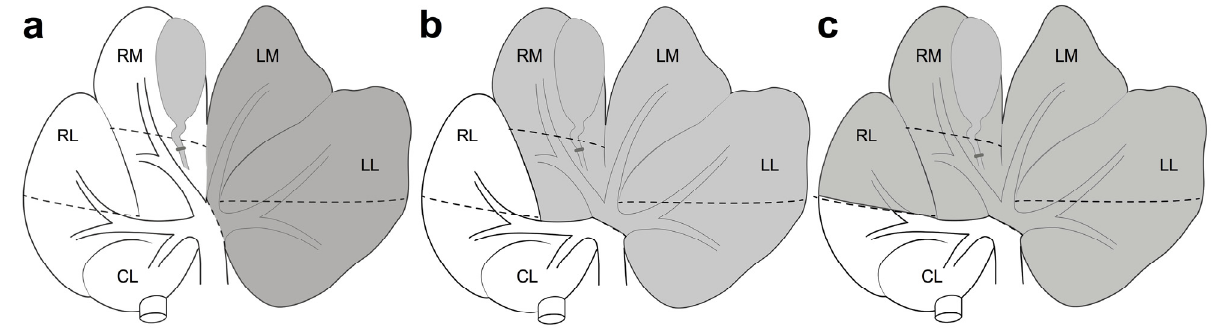
Figure 3. Major liver resections. The removed liver appears in grey. ( a ) 50% hepatectomy; ( b ) 70% hepatectomy; ( c ) 90% hepatectomy. Dashed lines represent the limits between liver segments (Sg).